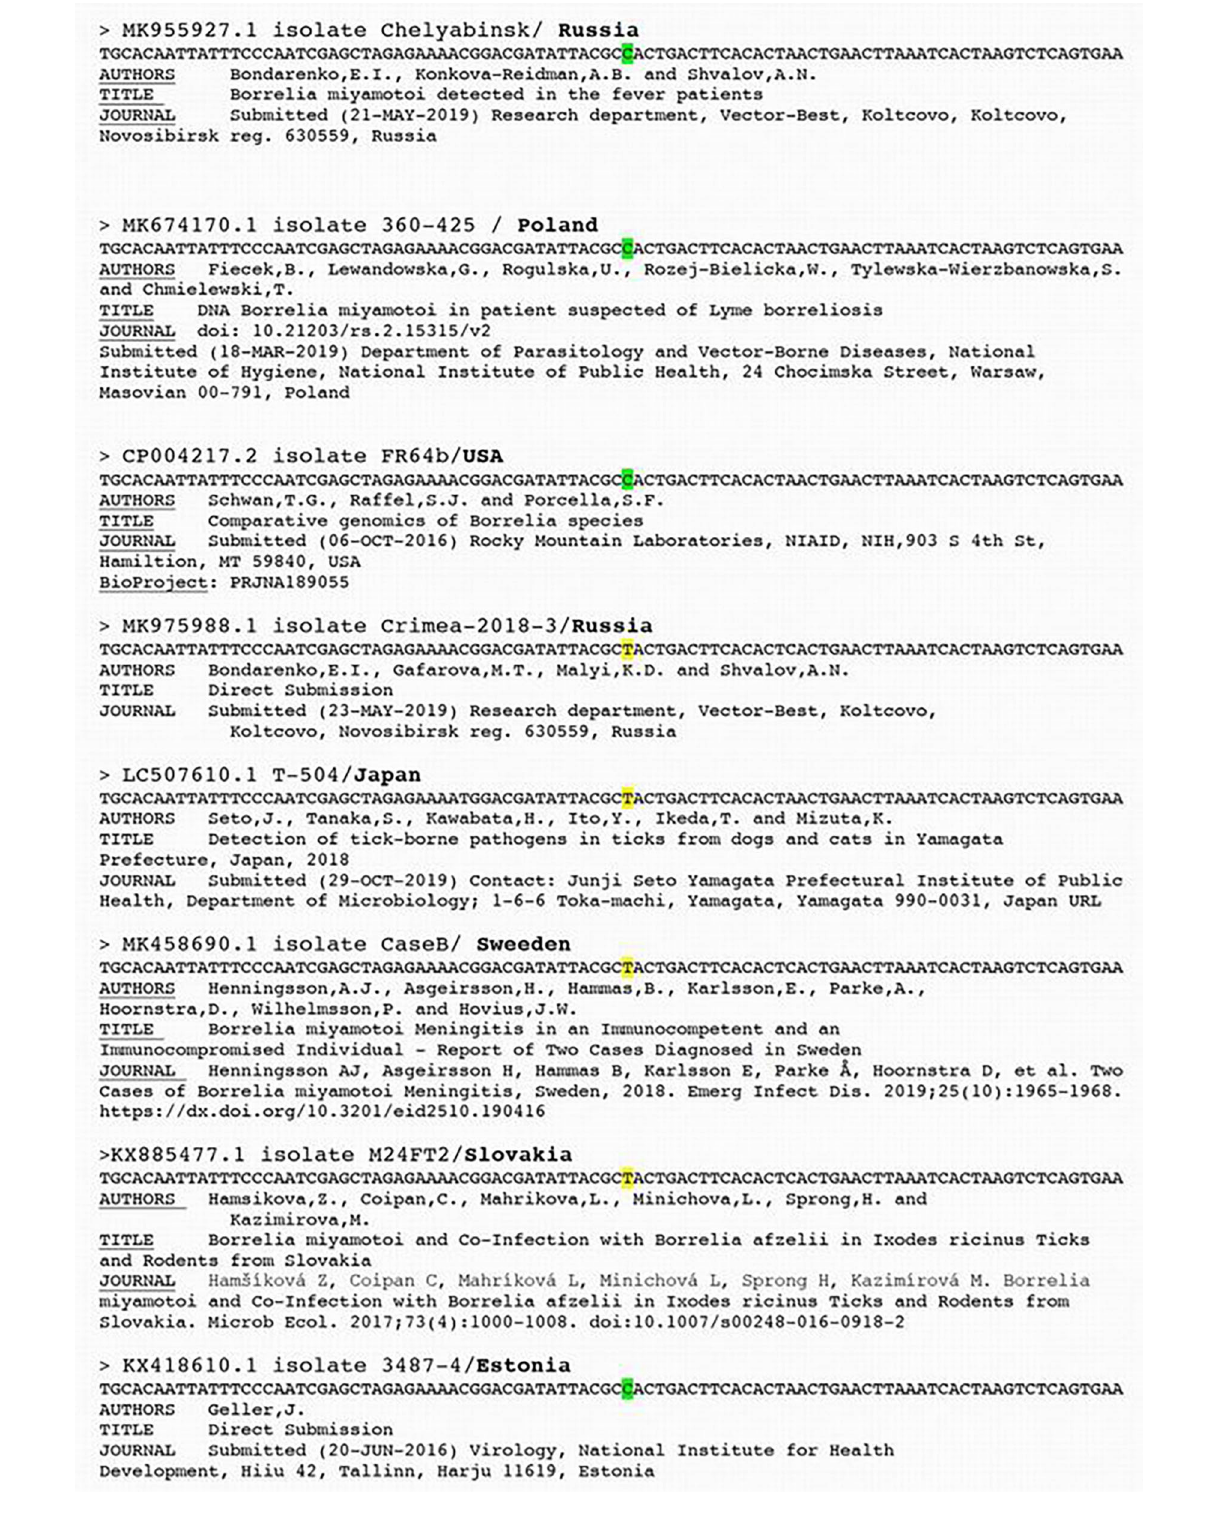
FIGURE 1 | Borrelia miyamotoi isolates DNA sequences alignment (source Genbank).